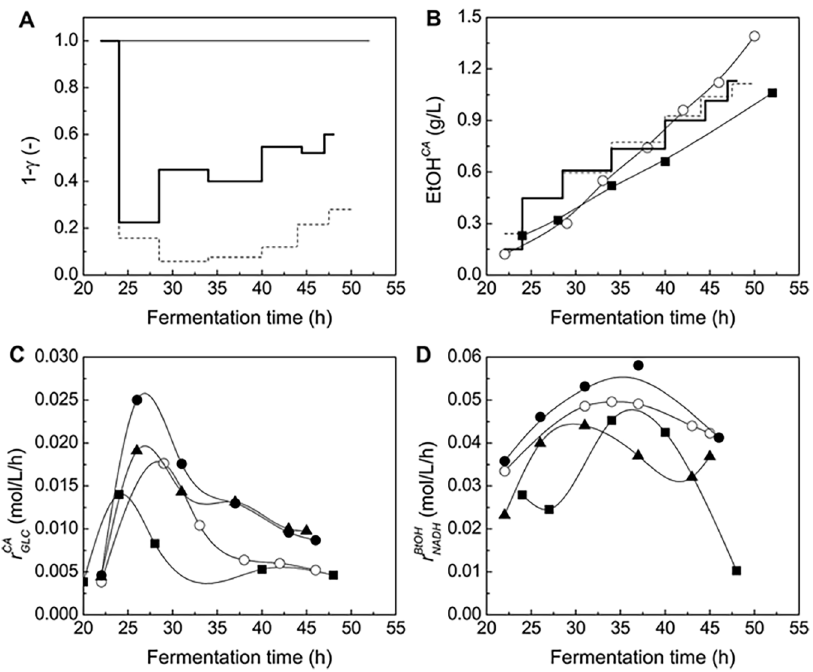
Fig 3. Theoretical analysis results of the major secondary parameters associated with ABE fermentation performance when using different operation strategies. (A) Contribution ratio of ethanol production by C . acetobutylicum . Thin line: ABE fermentation by C . acetobutylicum (control, case #a) and ABE fermentation by C . acetobutylicum with exogenous butyrate addition (case #b); broken line: ABE fermentation by co-culturing C . acetobutylicum / S . cerevisiae (case #c); bold solid line: ABE fermentation by co-culturing C . acetobutylicum / S . cerevisiae with butyrate addition (case #d). (B) Ethanol synthesis by C . acetobutylicum (EtOH CA ). ■ : case #a (control); (cid:6) : case #b; broken line: case #c; bold solid line: case #d. (C)- (D) Change patterns of r GLCCA and r NADHBtOH . ■ : case #a (control); (cid:6) : case #b; ▲ : case #c; ● : case